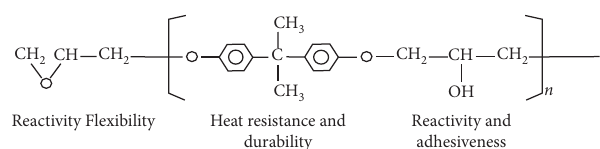
Figure 1: Structure of epoxy resin.